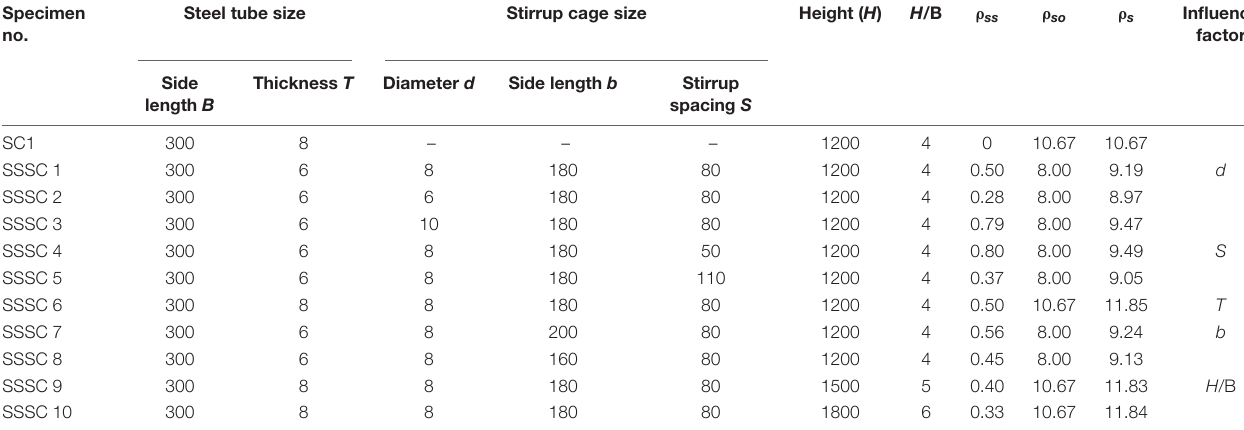
TABLE 1 | Design parameters of specimens. Specimen no.